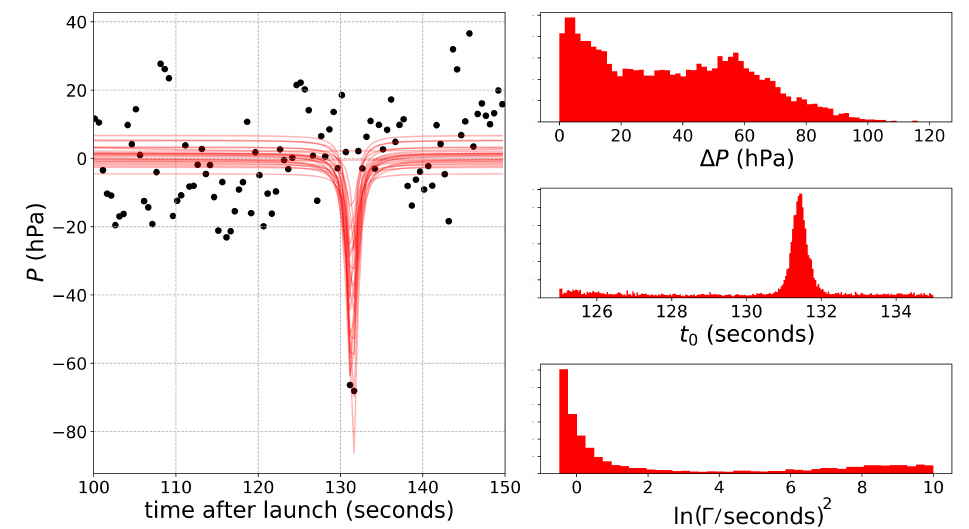
Figure 12. The left panel shows the Lorentz profile fit to a later part of the pressure time-series from Flight 2. The right panels show the best-fit parameters for